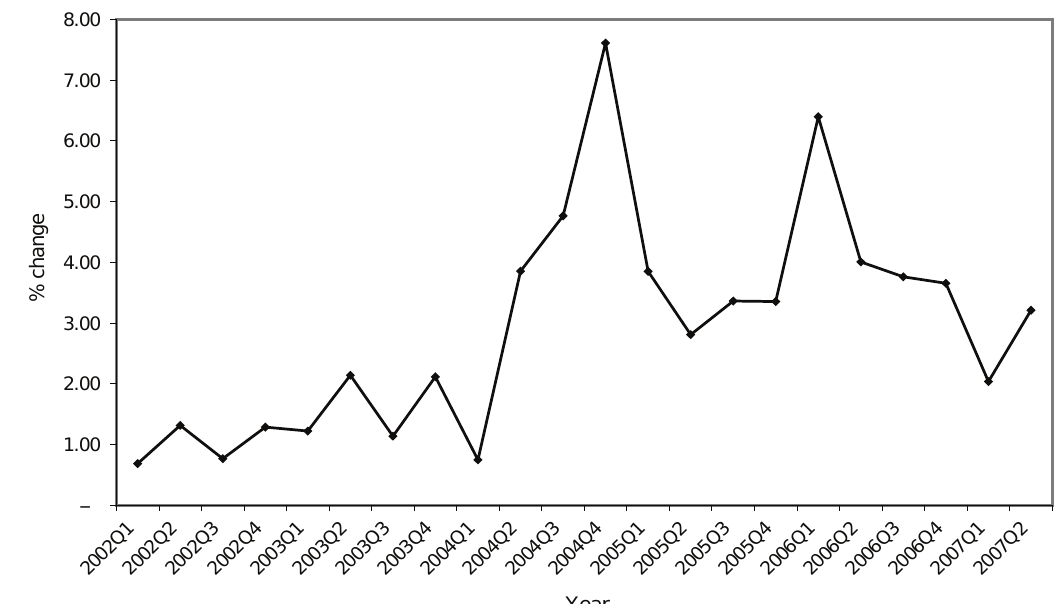
Figure 4. change in the all construction cost index (Quarterly